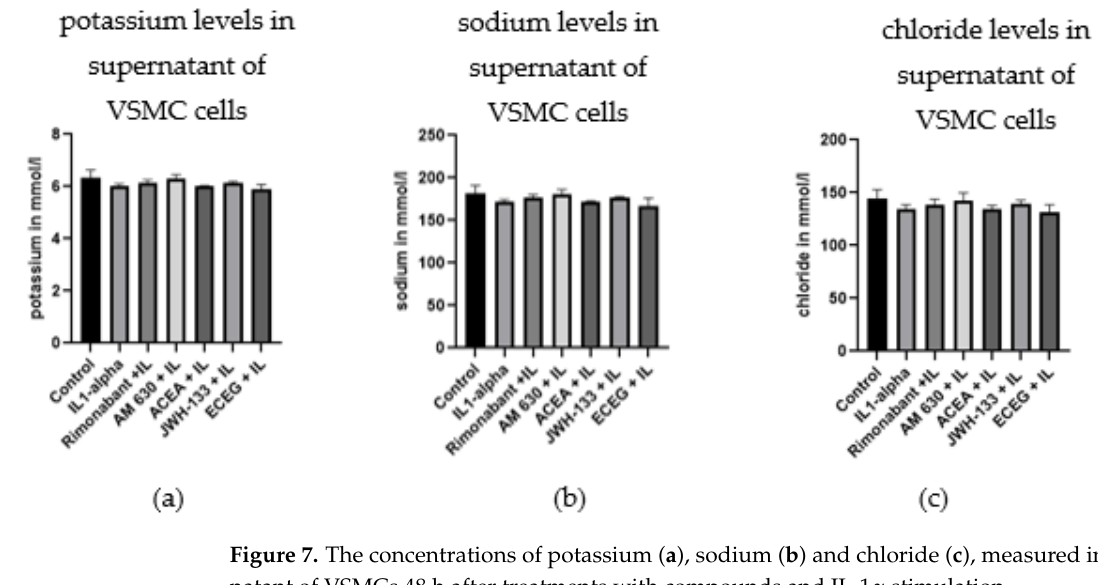
Figure 7. The concentrations of potassium ( a ), sodium ( b ) and chloride ( c ), measured in cell super- natant of VSMCs 48 h after treatments with compounds and IL-1 α stimulation.